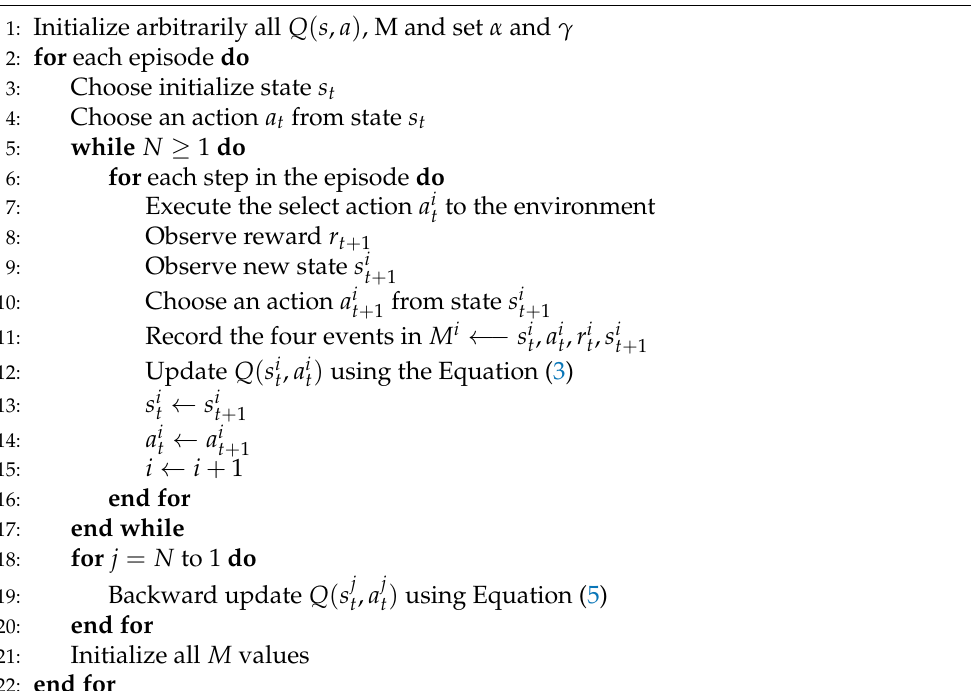
Algorithm 3 Backward